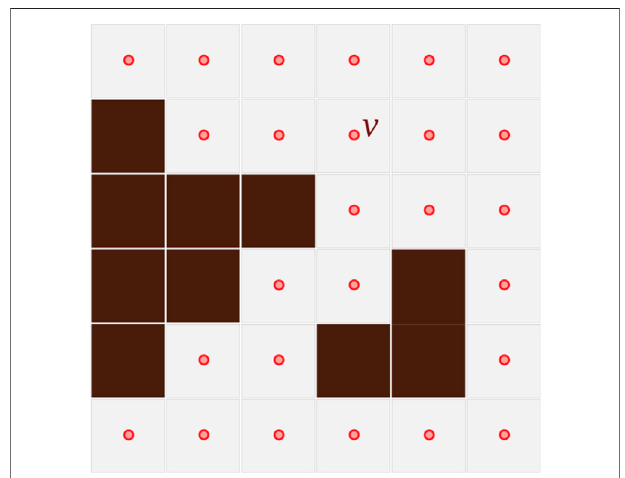
FIGURE1| Discreterepresentationoftheplanarcon fi gurationspace,C. Thedarkbrowncellsareinaccessible(obstacles),andavertexcorrespondsto each accessible cell.